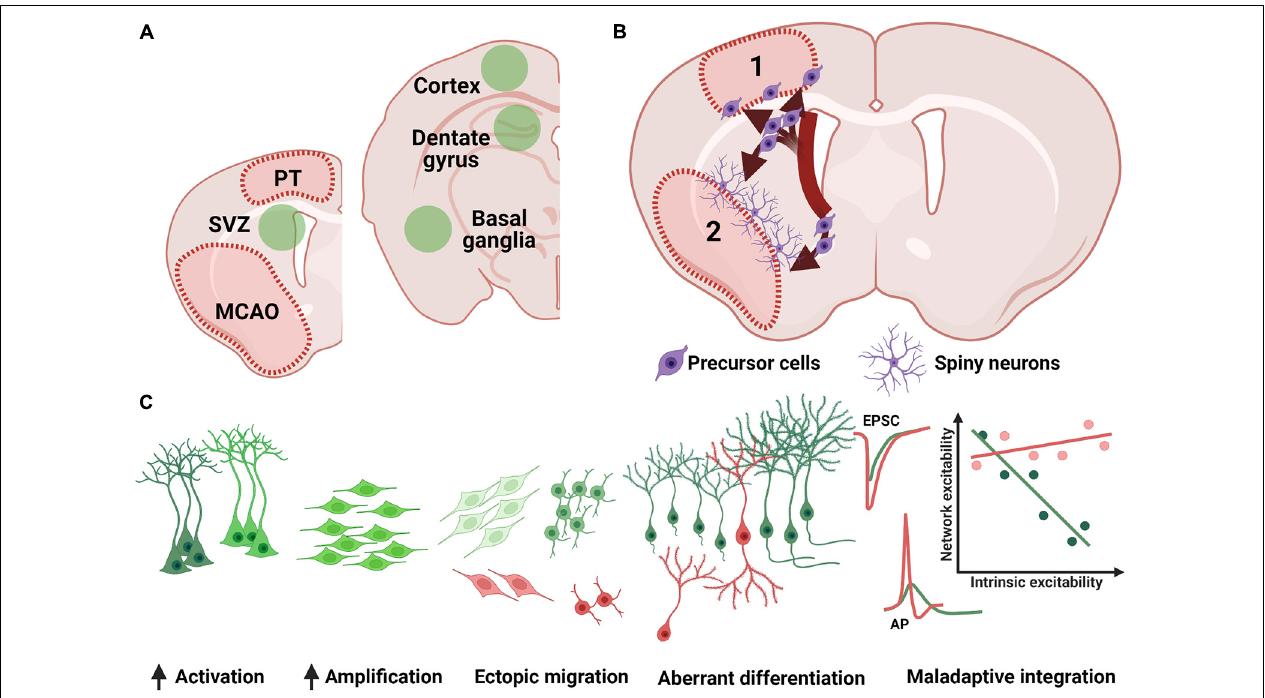
FIGURE 2 | Remote effects of stroke on adult neurogenesis. (A) Post stroke neurogenesis (green fields) has been detected in both canonical neurogenic niches (SVZ, subventricular zone; SGZ, subgranular zone) as well as in previously non-neurogenic regions (e.g., cortex and basal ganglia). (B) Increased SVZ proliferation is followed by ectopic migration in the cortex (1) or basal ganglia (2), where precursor cells are detected at the periphery of the lesion and develop into spiny neurons in the basal ganglia or form a more heterogenous cell group the cortex (see text for details). (C) SGZ neurogenesis shows a robust increase in cellular proliferation, although a subgroup of newly generated neurons (red cells) has been shown to migrate ectopically into the hilus, or otherwise present morphological (bipolar cells or changes in dendritic arborization) or functional (accelerated and uncoupled intrinsic and synaptic maturation) abnormalities. PT, photothrombosis; MCAO middle cerebral artery occlusion; EPSC, excitatory post-synaptic currents. AP, action